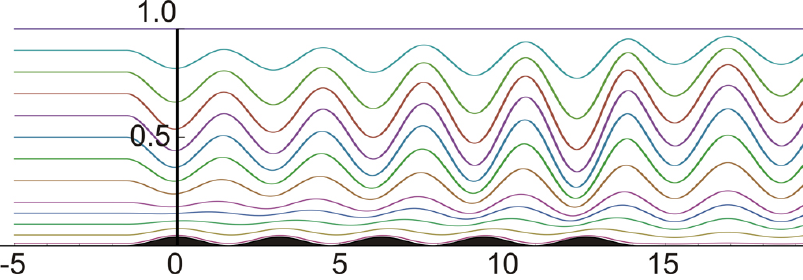
Fig. 4. Lee wave amplification: σ = 2 . 4.